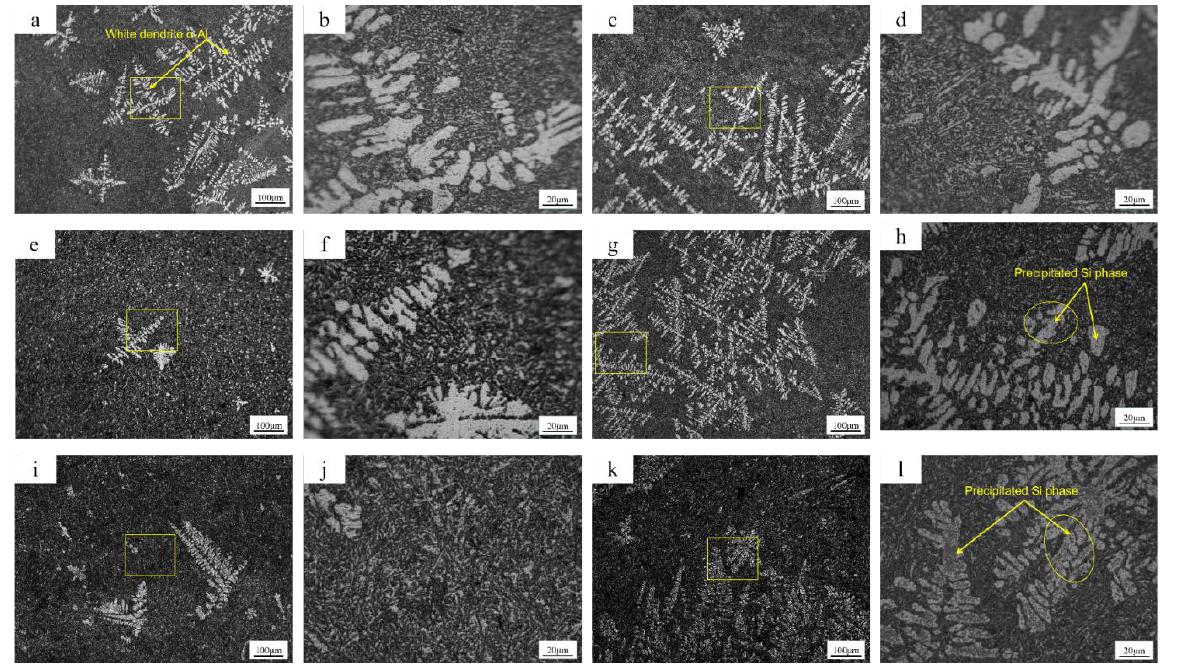
Figure 3. Representative OM images showing the distribution of the eutectic structure in the annealed Al-14.5Si alloys under a super-gravity field: ( a , b ) A-0; ( c , d ) A-0.25; ( e , f ) A-0.5; ( g , h ) A-1; ( i , j ) A-2; ( k , l ) A-4.